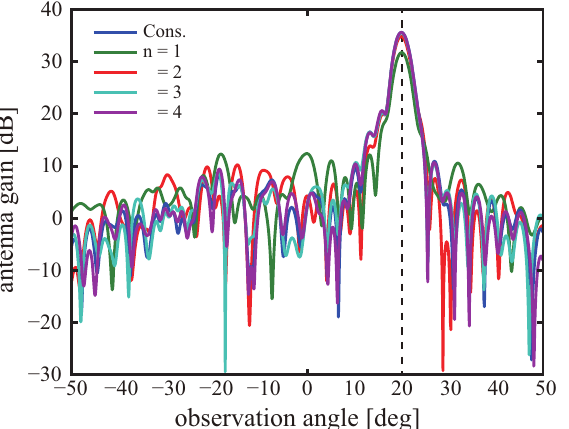
Figure 6. Simulated far-field patterns in H-plane of digitized reflectarray antennas when the re- radiation field is directed at θ = 20 ◦ .